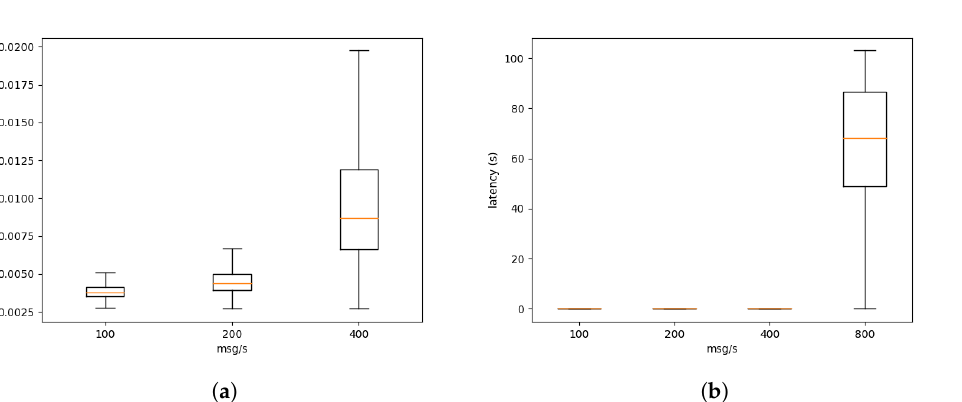
Figure 4. Latency at the bridge level. Due to the scaling issues ( a ) only shows from 100 to 400 msg/s while ( b ) shows from 100 to 800